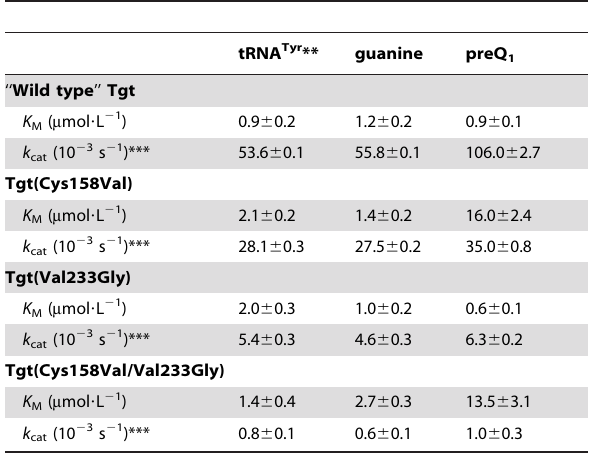
Table 1. Kinetic parameters for ‘‘wild type’’ Tgt and mutated Tgt variants.